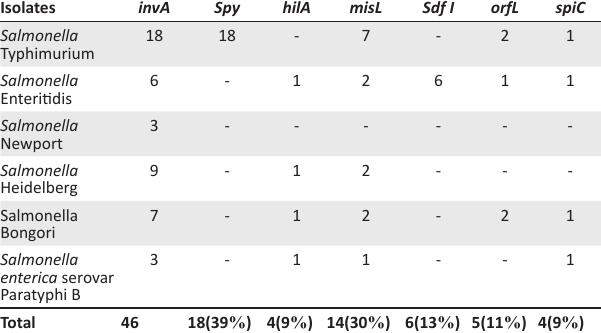
FIGURE 2: The phylogenetic relationship of Salmonella detected in the faeces from chickens. The tree was clustered with the neighbour-joining method using MEGA 7 package. Bootstrap values based on 1000 replications were listed as percentages at the nodes. The GenBank accession numbers are indicated at the branches of the tree. The scale bar indicates 0.01 substitutions per nucleotide position. Bootstrap values > 60 % are TABLE 3: Prevalence of detected virulence genes from Salmonella isolates.